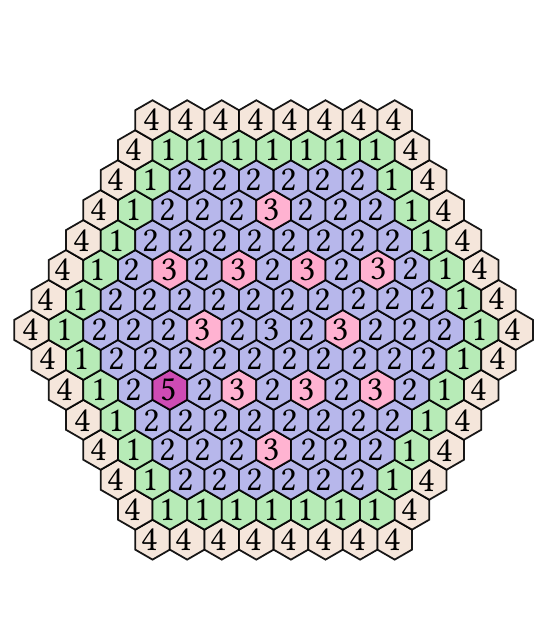
Figure 1: Materials layout in the 2D-IAEA benchmark.